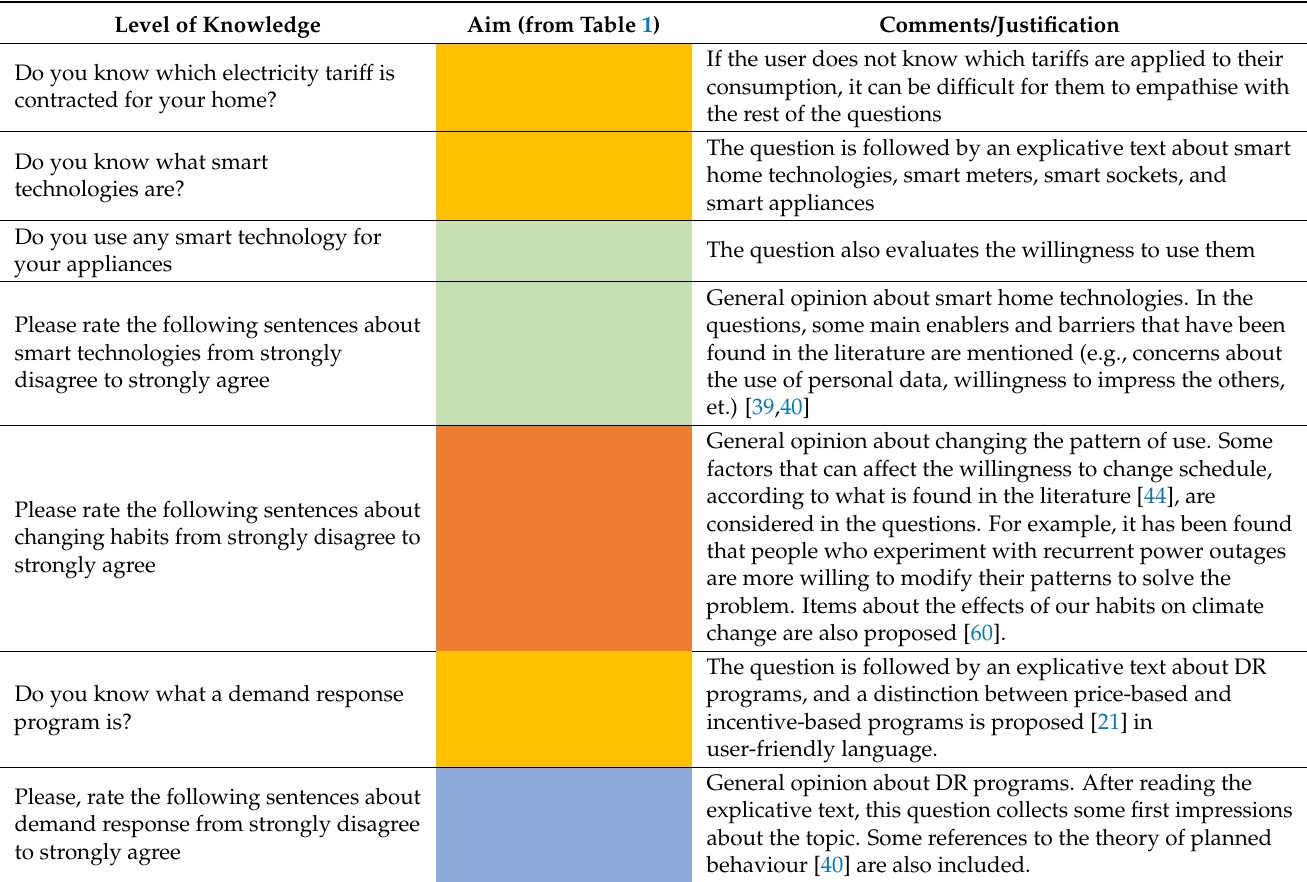
Table 3. Questionnaire—level of knowledge section. For the colour legend and the corresponding sub-objectives, please refer to Table